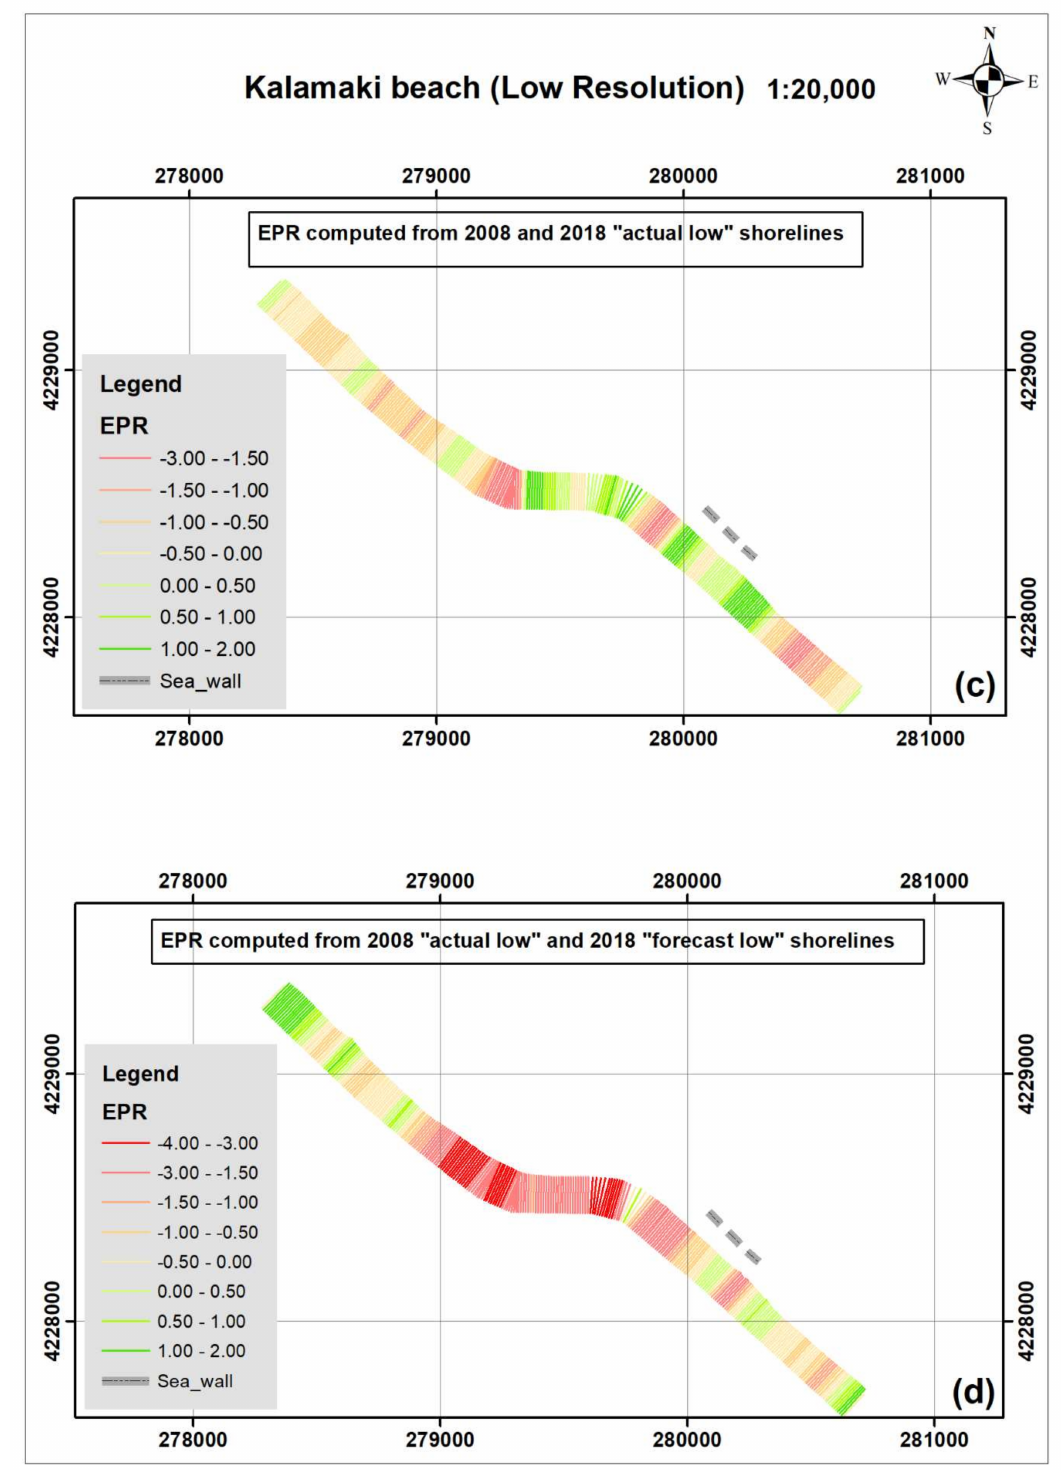
Figure 11. End point rate (EPR) rates were computed for the 2008–2018 period from both low- and high-resolution data using the 2008 and 2018 “actual” shorelines and the 2018 “forecasted” shorelines for Kalamaki